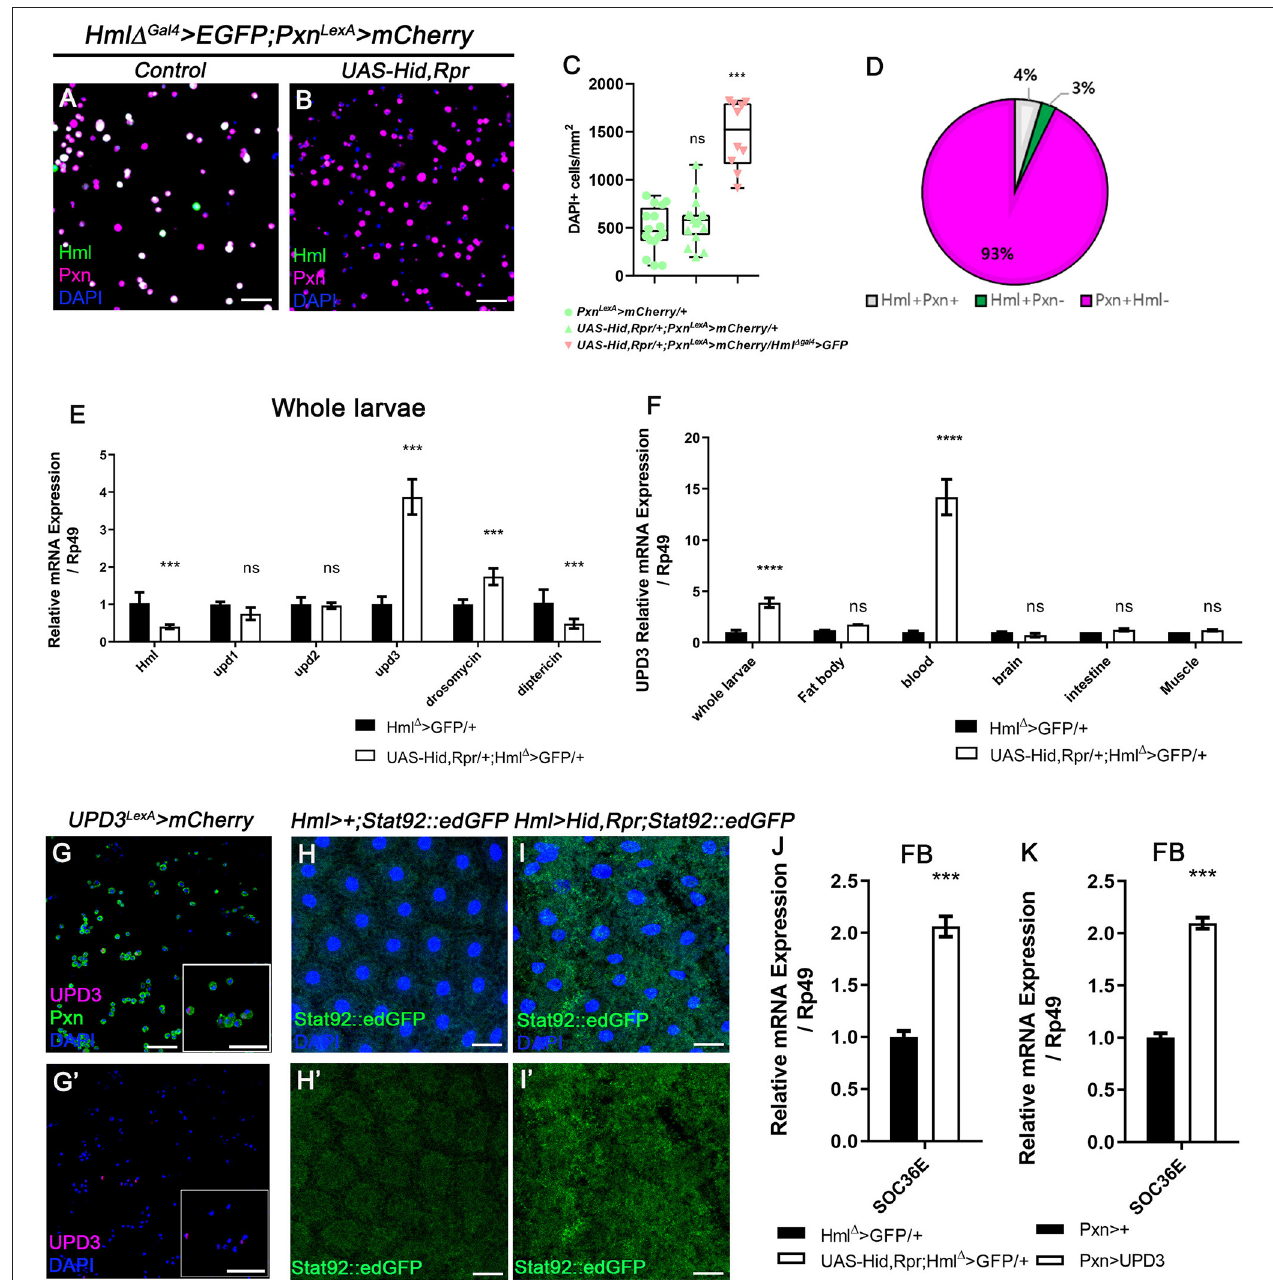
FIGURE 2 | Ablation of Hml + hemocytes increases the number of circulating and sessile hemocytes, and induces upd3 expression. (A,B) Expression of Pxn (magenta) in Hml 1 -Gal4 UAS-EGFP, Pxn-LexA LexAop-mCherry background. Compared to hemocytes sampled from wild type (A) , the genetic ablation of Hml + cells increases the number of Pxn + (magenta) cells ( Hml 1 -Gal4 UAS-EGFP UAS-hid,rpr, Pxn-LexA LexAop-mCherry ) (B) . Hml (green), Pxn (magenta), and DAPI (blue). Scale bar, 40 µ m. (C) Quantitation of circulating and sessile hemocytes in genetic backgrounds used in (A,B) . Graphs indicate median plots of DAPI positive cells per mm 2 in each genotype. Highest and lowest bars indicate maximum and minimum values, respectively. Controls (green) ( Pxn-LexA LexAop-mCherry or UAS-hid,rpr; Pxn-LexA LexAop-mCherry ), Hml ablated background (pink) ( Hml 1 -Gal4 UAS-EGFP UAS-hidrpr; Pxn-LexA LexAop-mCherry ). Statistical significance was determined by t-test . *** p < 0.001; not-significant, ns. (D) Pie chart shows the proportion of Hml + Pxn + (white), Hml + Pxn − (green), or Pxn + Hml − (magenta) in circulating and sessile plasmatocytes of Hml + ablated background ( Hml 1 -Gal4 UAS-EGFP UAS-hidrpr; Pxn-LexA LexAop-mCherry ). Quantitation of (B) . (E,F) mRNA levels of signaling molecules and antimicrobial peptides in Hml + ablated background ( Hml 1 -Gal4 UAS-hid,rpr ). RT-qPCR analysis of genes related to active immunity normalized by rp49 using whole larvae (E) . upd3 expression in relevant organs (F) . upd3 expression is highly increased in whole larvae (E) , and hemocytes show identical increase in upd3 (F) . Statistical analyses were performed using two-way ANOVA in whole larvae and organs. *** p < 0.001; **** p < 0.0001; not significant, ns. (G,G’) upd3 (magenta;